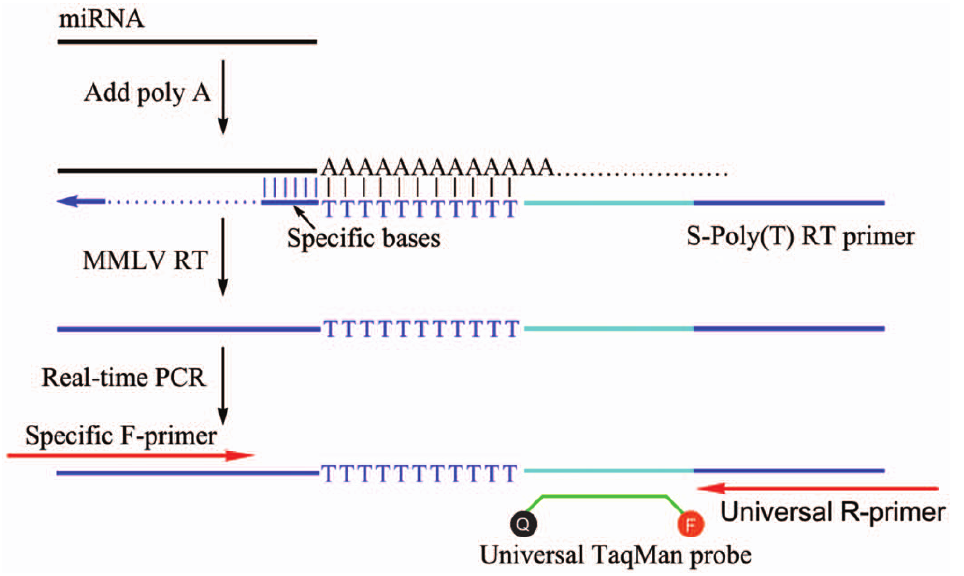
Figure 1. Schematic representation of the S-Poly(T) method for miRNA quantification. miRNAs are subjected to polyadenylation and subsequent reverse transcription with miRNA-specific S-Poly(T) RT primers. The S-Poly(T) RT primers consist of four segments, in the 5 9 to 3 9 direction, a universal reverse primer sequence for PCR, a universal Taqman probe sequence and an oligo(dT) 11 , followed by 5 , 7 specific bases that are complementary to the 3 9 end of a particular mature miRNA. PCR products were generated with a miRNA-specific forward primer and a universal reverse primer and detected by a universal Taqman probe.